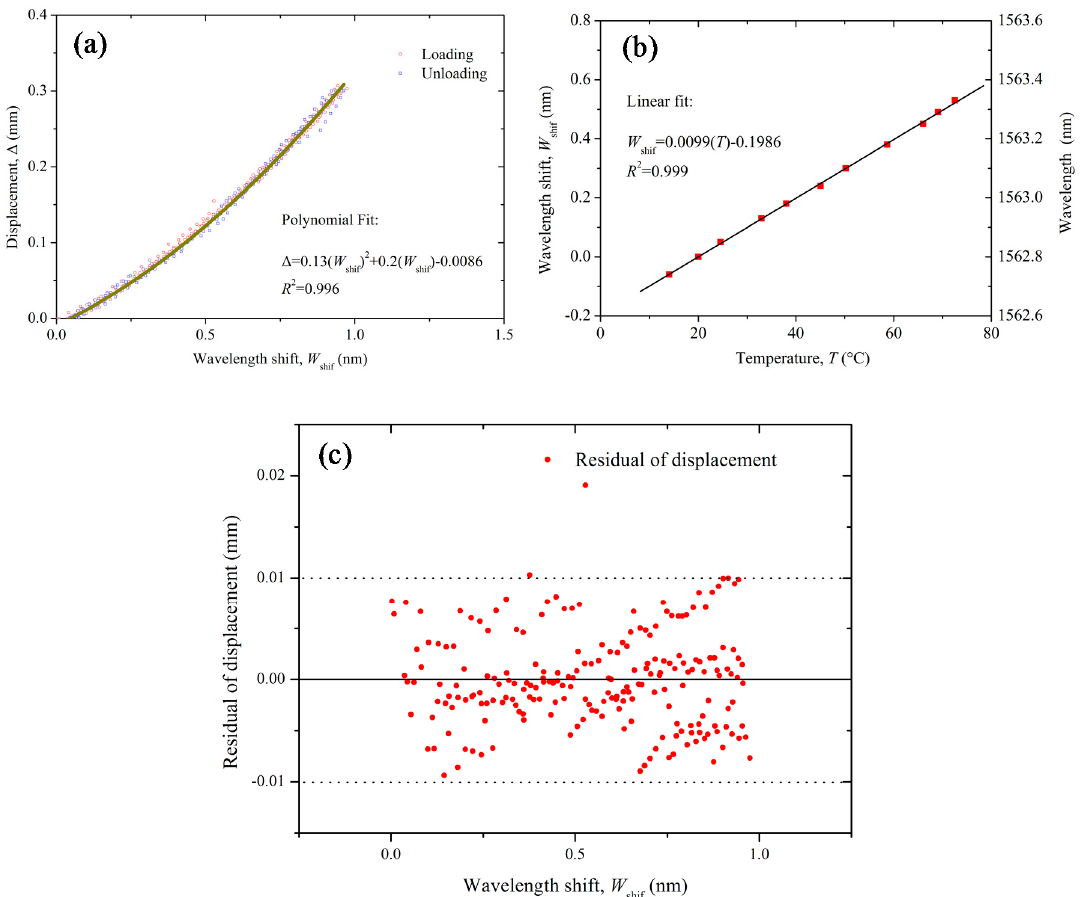
Figure 6. Calibration results of the SDT: ( a ) calibration results of SDT deformation versus wavelength shift of the FBG sensor; ( b ) calibration results of wavelength shifts versus temperatures changes; and ( c ) residual analysis of the polynomial fit in figure ( a ): residual of displacement versus wavelength shift, W shif .